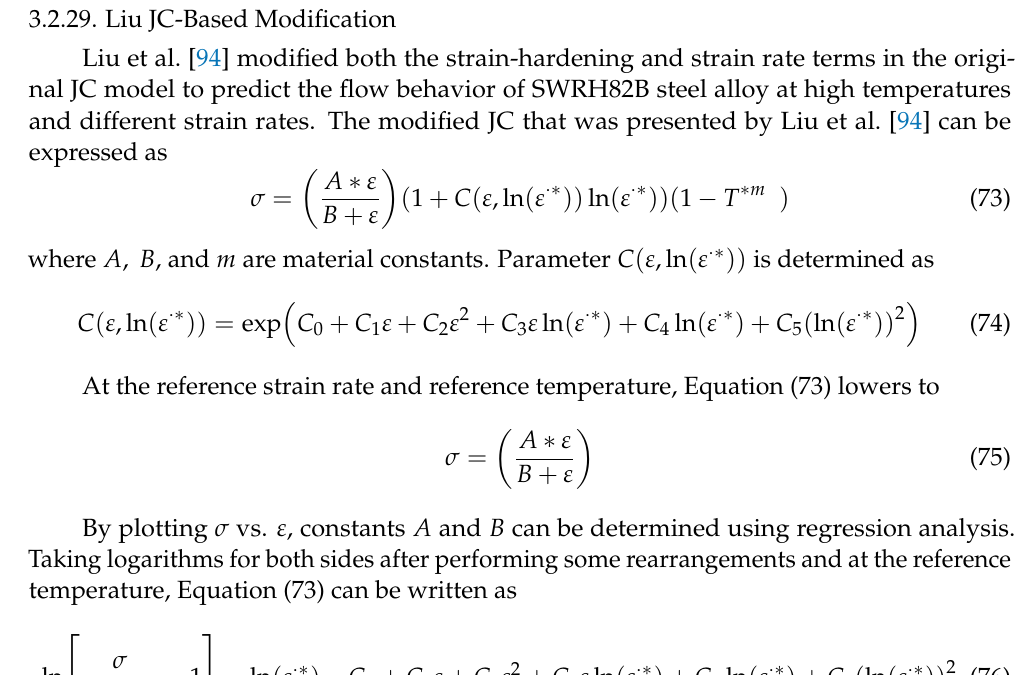
Figure 46. Comparison between experimental stresses (markers) and predicted stresses (solid lines) for CuCrZr alloy obtained by ( a ) the original JC model and ( b ) the modified JC model that was presented by Qian et al. [93].